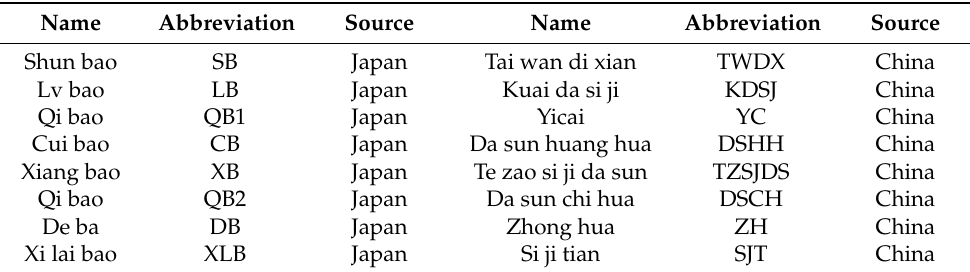
Table 1. Name and source of experimental Chinese kale varieties.